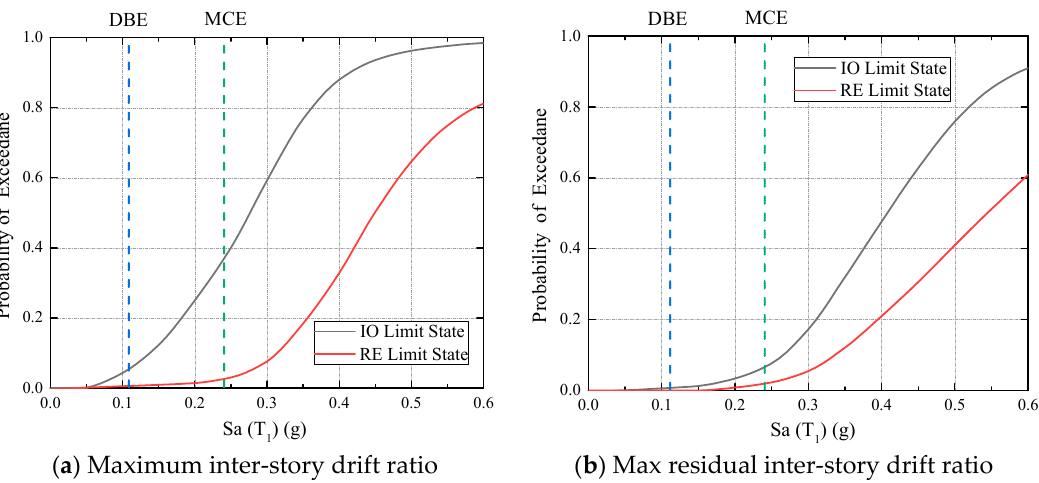
Figure 21. Fragility curves of novel SCPC frames (engineering demand parameters (EDP) of θ max and θ r,max ). Table 3. Exceeding probabilities of the two performance limit states.